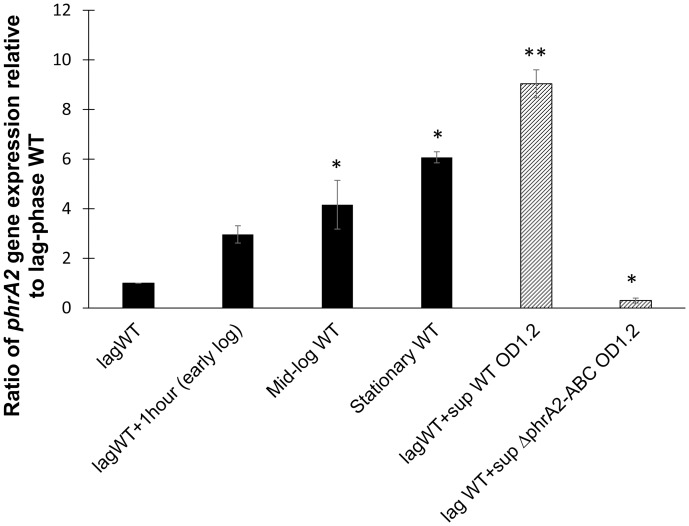
Density-dependent gene expression and extracellular secretion of phrA2 during planktonic growth.qRT-PCR measurements of phrA2 gene expression in PN4595-T23. The Y-axis displays expression levels as a ratio to expression in lag phase culture. The X-axis denotes culture conditions. Black bars displays density-dependent gene expression at lag phase (OD6000.05), early-log phase (OD6000.2), mid-log phase (OD6000.6), and stationary phase (OD6001.0). Striped bars display treatment by cell-free supernatants. The lag phase culture was divided into three tubes and grown for 1h in one of three ways in: original supernatant (lagWT+1hour), cell-free supernatant from a high density wild type culture (OD6001.2), or cell-free supernatant from a high density ΔphrA2-ABC culture (OD6001.2). 16SrRNA was used as normalization control. Error bars represent standard deviations from biological duplicate experiments. ‘**’ P-value<0.01 and ‘*’, P-value<0.05 as determined by Student’s t-test.